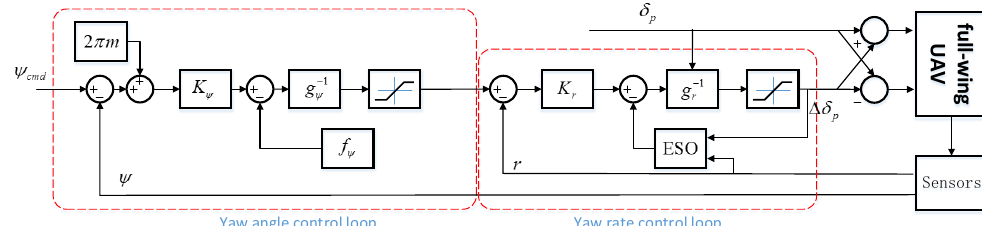
Figure 5. Structure diagram of lateral-directional attitude control law. ESO, extended state